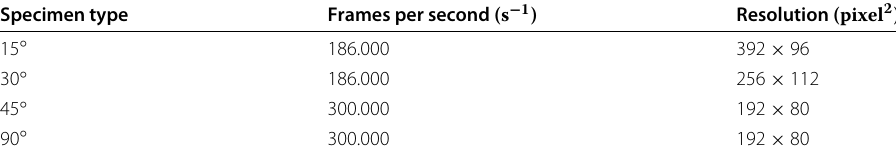
Table 1 Setup parameters of high speed camera Specimen